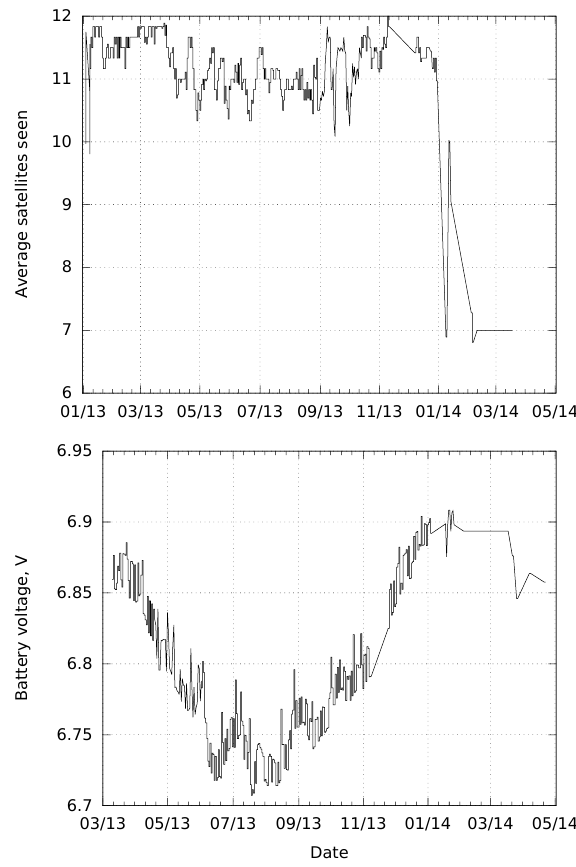
Figure 9. Battery voltage and satellite reception performance of the two ADIOS iceberg tracker units located on iceberg B-31.